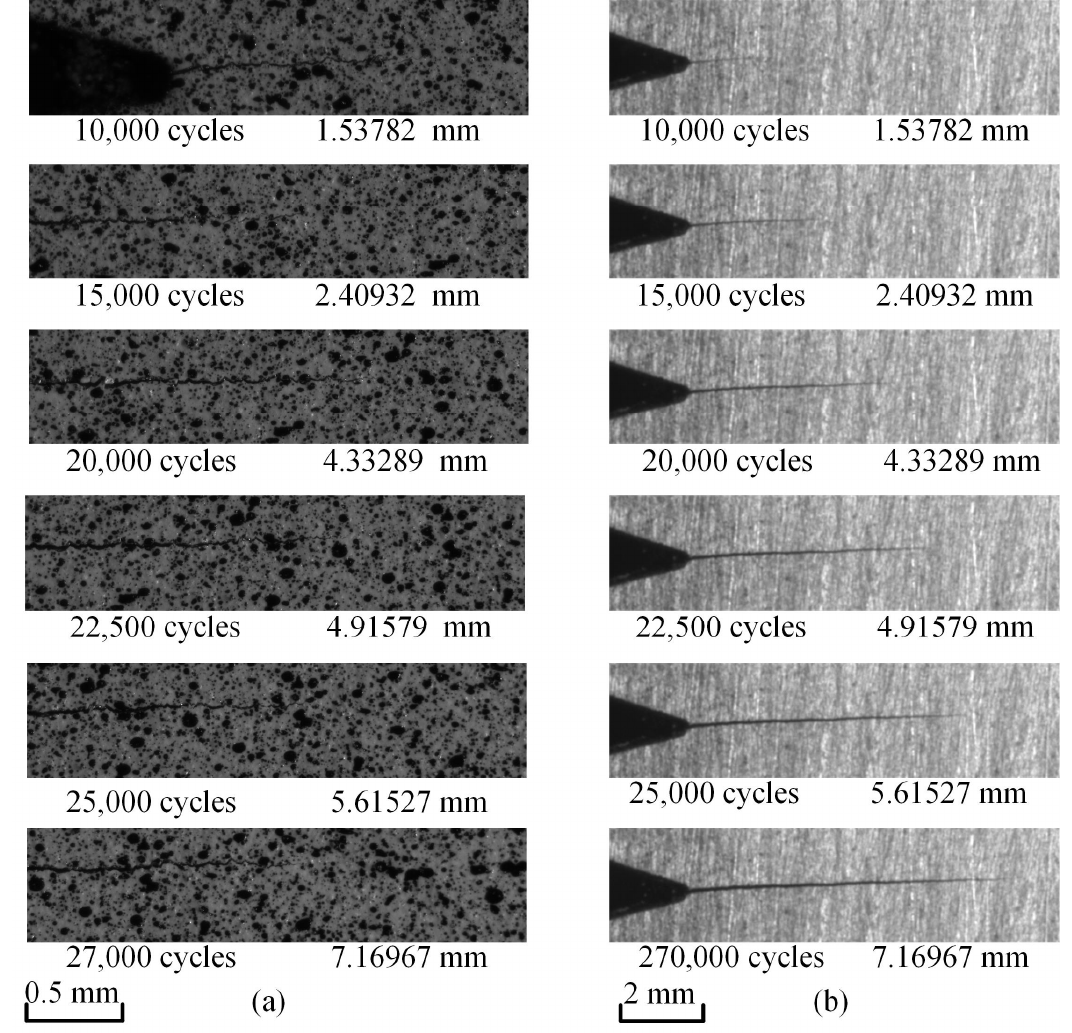
Figure 7. Maximum load point images corresponding to different cycle numbers: ( a ) Speckle images; ( b ) global crack images.